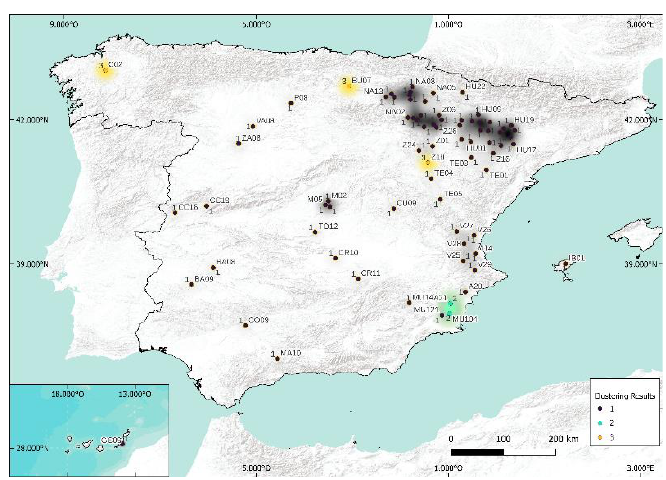
Figure 19. Using hierarchical for 3 clusters .